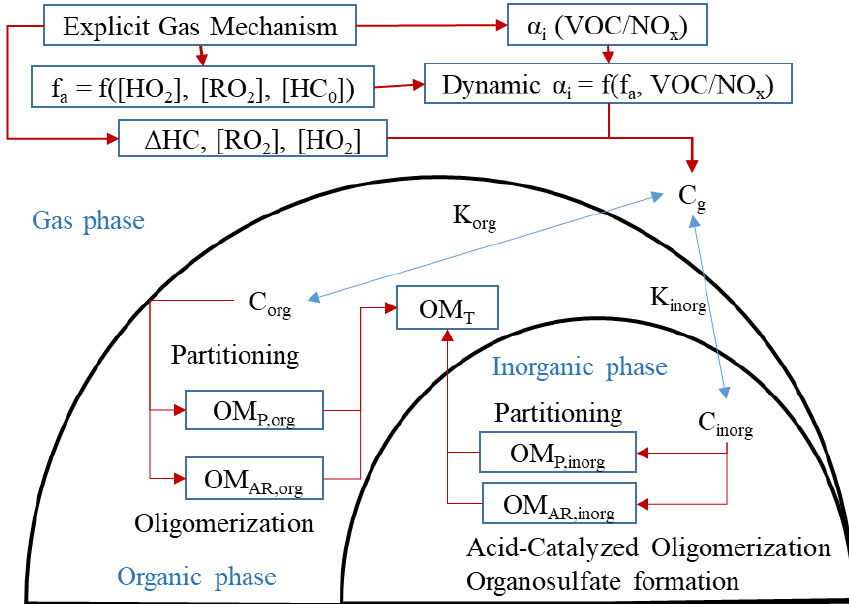
Figure 1. A simplified scheme of the UNIPAR model. [HC] 0 represents the initial hydrocarbon (HC) concentration. A gas kinetic mechanism (MCM v3.3.1 + autoxidation of alkyl peroxy radicals) is used to simulate the consumption of HC ( (cid:49) HC) as well as the concentrations of the hydroperoxide radical ([HO 2 ]) and organic peroxyl radical ([RO 2 ]). The explicit gas mechanism of each alkane is used to derive the dynamic mass-based stoichiometric coefficient (dynamic α i ) of lumping species i as a function of HC / NO x and the aging factor f a . f a is represented as a function of [HO 2 ], [RO 2 ], and [HC] 0 (Zhou et al., 2019). Subscripts g, org, and inorg denote the gas, organic, and inorganic phases, respectively. K org and K inorg represent the partitioning coefficients of lumping species to the org phase and inorg phase, respectively. C org and C inorg represent the concentrations of lumping species in the org and inorg phases, respectively. OM P , org and OM P , inorg represent the mass of organic matter (OM) present in org and inorg phases, respectively, due to partitioning. OM Ar , org and OM AR , inorg represent the OM formed in the org phase due to in-particle chemistry, such as oligomerization, and inorg phase due to acid-catalyzed oligomerization and organosulfate formation (Beardsley and Jang, 2016; Im et al., 2014; Zhou et al., 2019). OM T represents the total SOA mass formed due to partitioning and aerosol-phase reactions in both the inorg and org